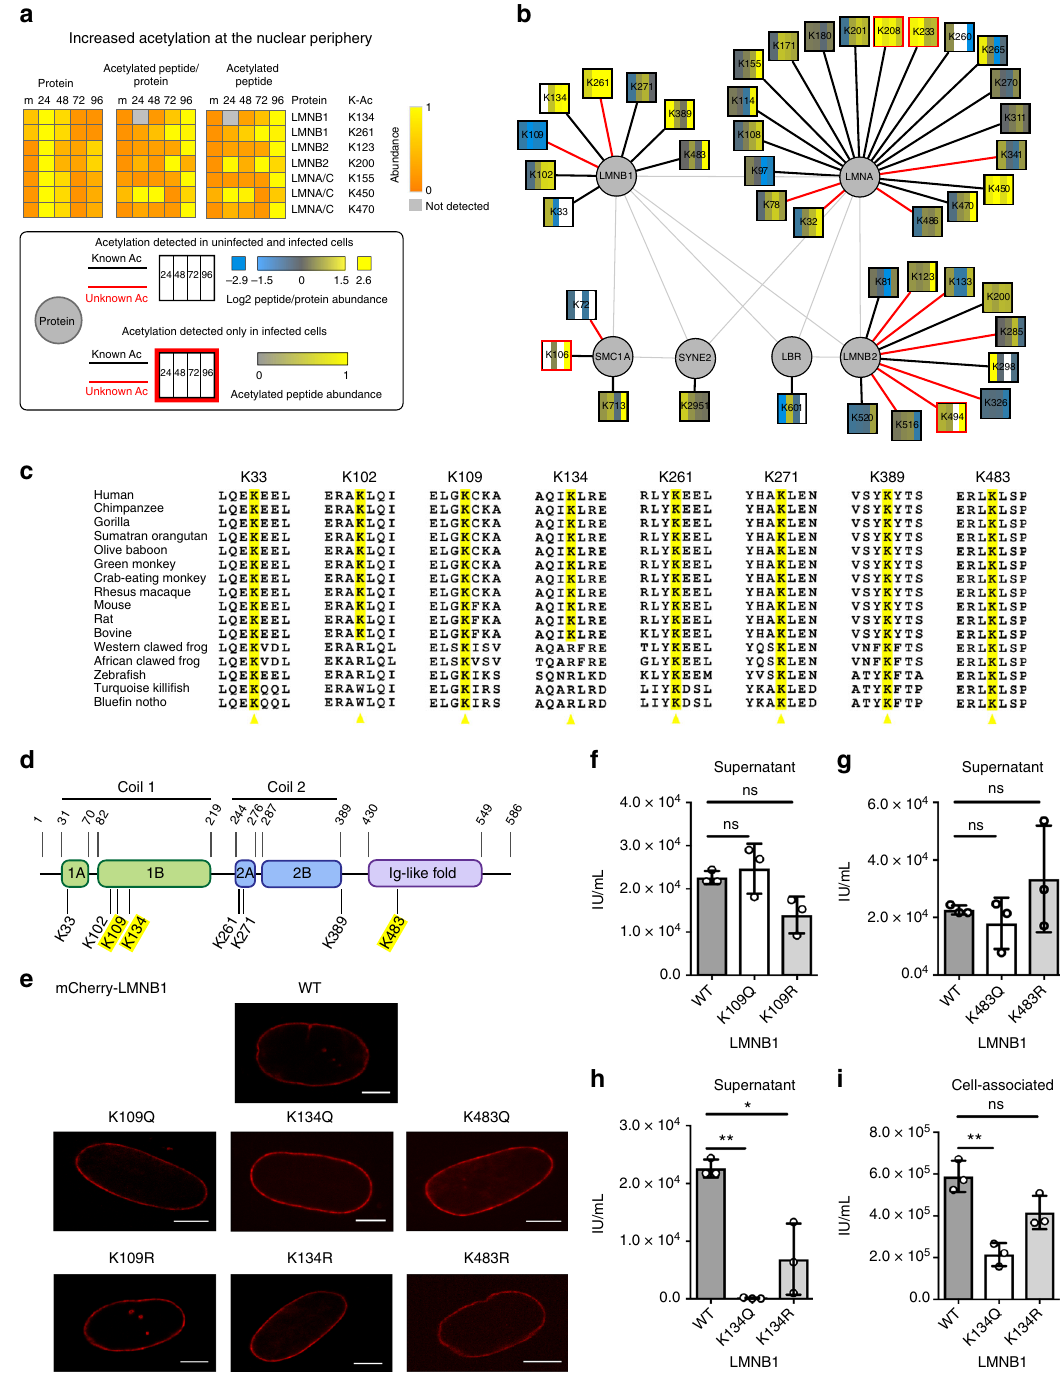
Fig. 5 Functional acetylation at the nuclear periphery during HCMV infection. a Nuclear periphery proteins with increased levels of acetylation during infection, scaled from 0 to 1 (left, protein abundance; middle, peptide acetylation level normalized to protein abundance; right, peptide acetylation level) b Acetylation sites detected on lamin and lamin-associated proteins. c Sequence alignment of identi fi ed LMNB1 acetyl-lysines from selected animal species. The identi fi ed acetyl-lysine residues are highlighted and the six fl anking residues were excerpted for representation. d Schematic of LMNB1 protein domains with detected acetylated sites; upper amino acids demarcate domains; lower, acetylated lysines; yellow, acetylation sites that were pursued in this study. e Representative images of MRC5 cells transfected with all seven mCherry-LMNB1 constructs indicated. All constructs localize to the nuclear periphery and do not alter nuclear morphology. Scale bar = 5 μ m. f – h Effect of LMNB1 mutants on extracellular virus produced. Cells expressing either wild- type (WT) or mutant LMNB1 were infected, and the supernatant collected at 120 hpi was then used to infect a reporter plate of fi broblasts. Titer (IU/mL) was measured by staining the reporter plate for viral immediate early protein IE1. Average of three biological replicates ± SD using a two-sided Student ’ s t test, * p value ≤ 0.05, ** p value ≤ 0.01. i Cell-associated virus was collected and used to infect a reporter plate. Titer (IU/mL) measured via IE1 staining, ** p value ≤ 0.01. Source data are provided as a Source Data fi